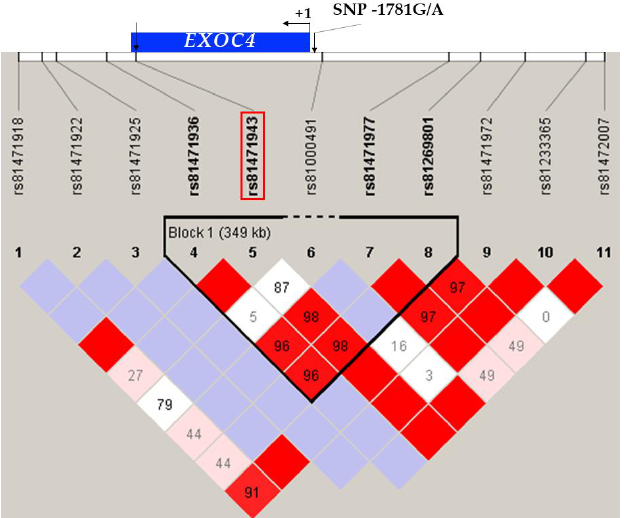
Figure 1. Schematic diagram of the EXOC4 structure. Notes: The linkage disequilibrium (LD) plot within +/ − 100 Kb of the EXOC4 gene was computed by Haploview. The color of each square from light to dark (white to red) indicates the degree of LD from low to